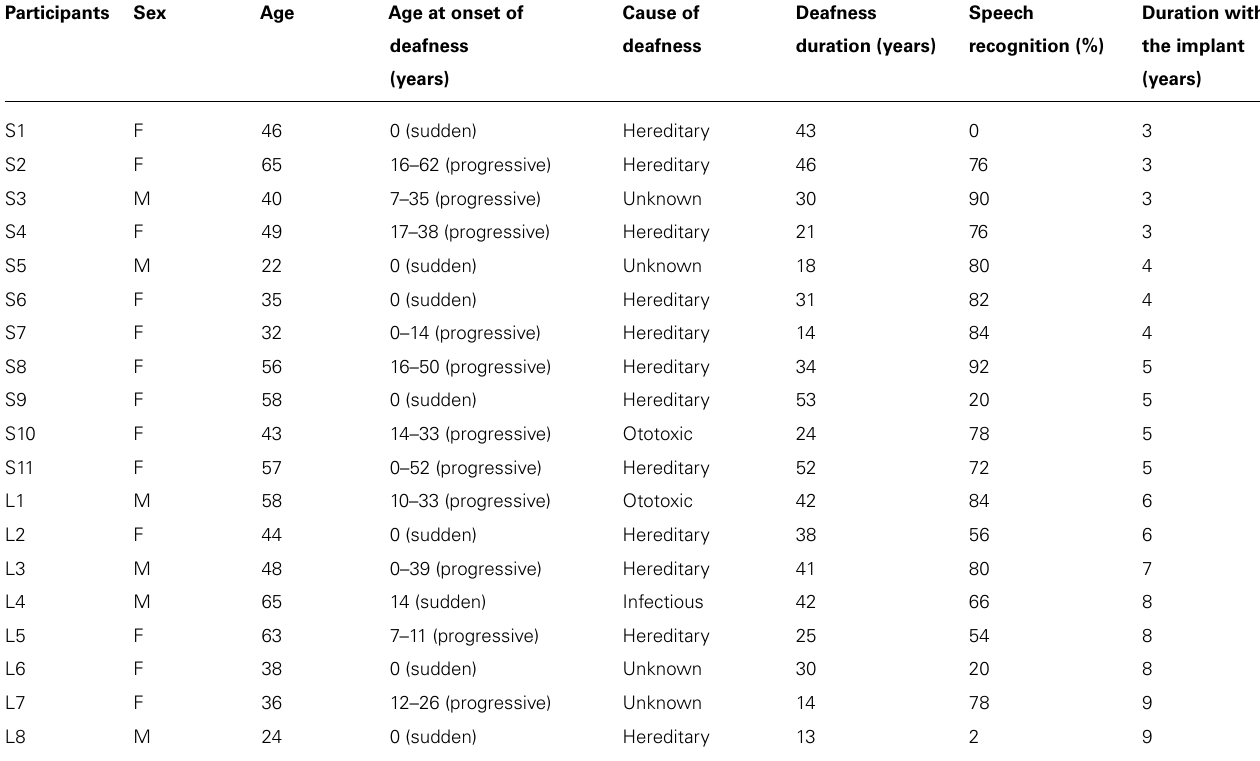
Table 1 | Clinical profile of cochlear implant users. Participants